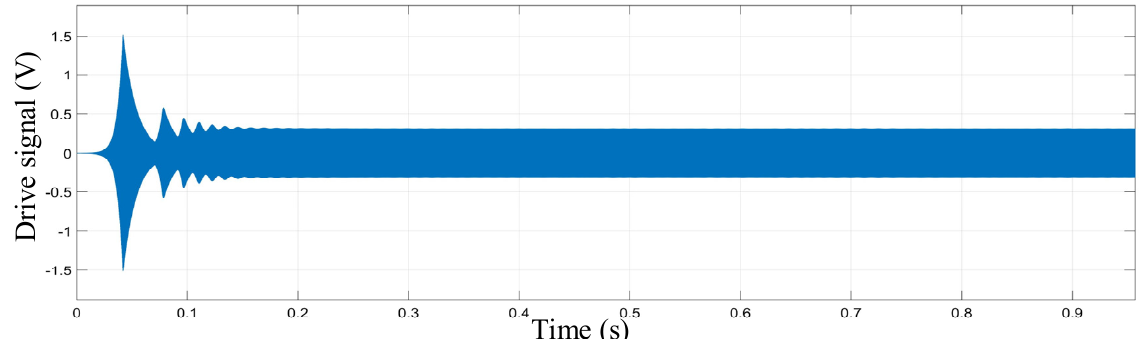
Figure 7. Simulation diagram of self-excited oscillation of the driving circuit.